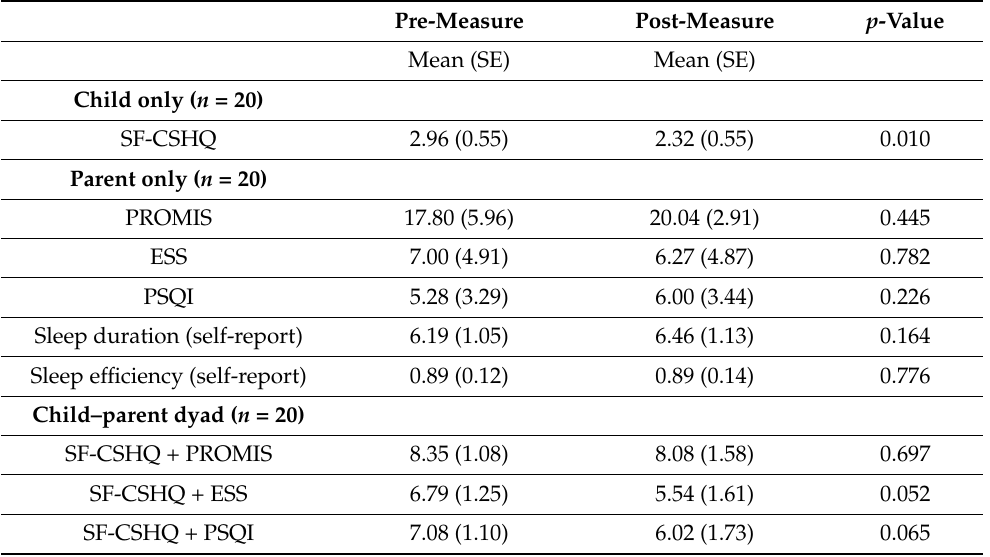
Table 3. Pre-intervention vs.